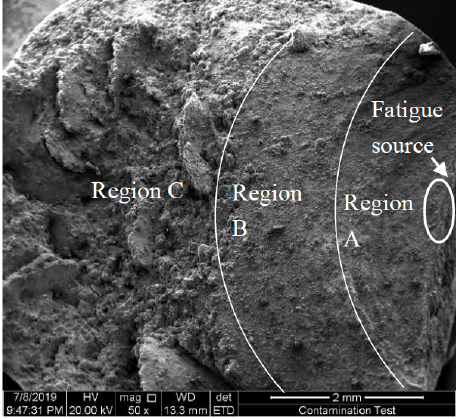
Figure 11. Macroscopic morphology of fatigue crack propagation.